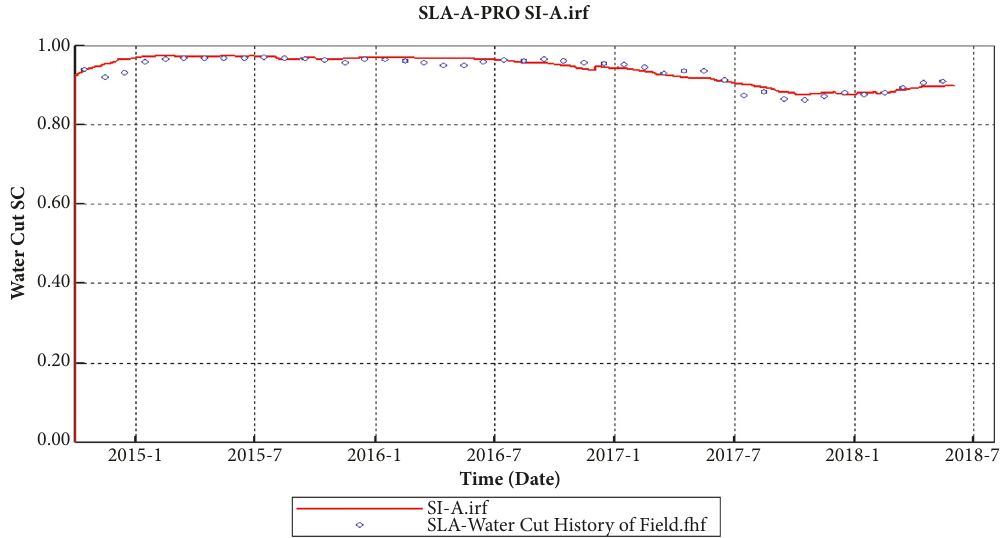
Figure 12: SL-A block comprehensive water cut curve.